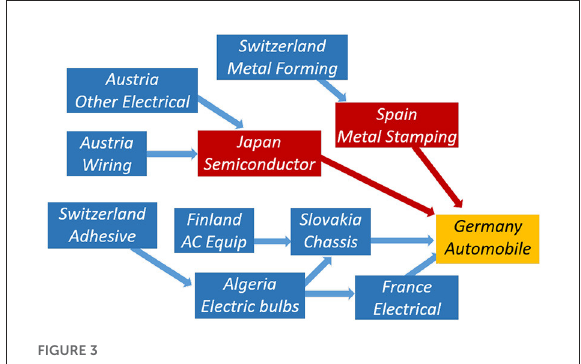
FIGURE3 Hybrid network merging product dependency and UN commodity Trade statistic data and disruption from Figure 1.